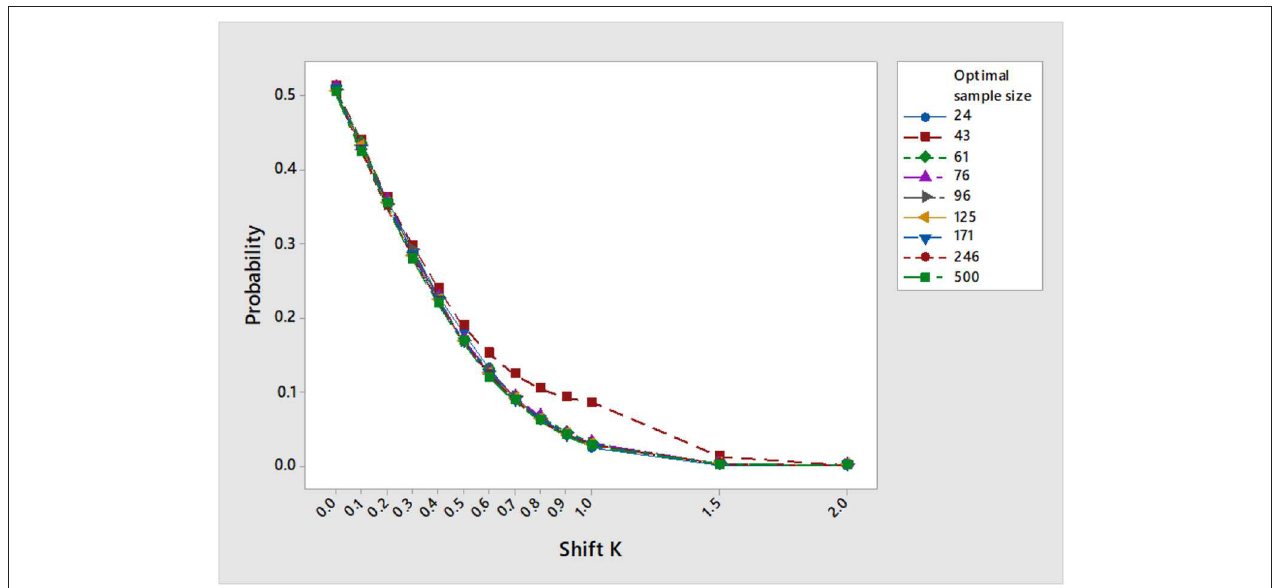
FIGURE 3 | Operating characteristic values under uncontrolled optimal sample size as the shift increases at µ